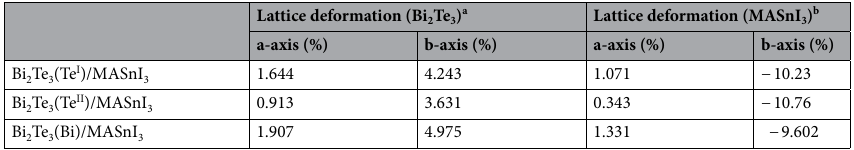
Table 2. Lattice deformation ratios of various interfaces after structural optimization. a This value represents the lattice deformation ratio of the Bi 2 Te 3 structure in the interface model based on the bulk orthorhombic Bi 2 Te 3 bulk structure before optimization. b This value represents the lattice deformation ratio of the MASnI 3 structure in the interface model based on the tetragonal MASnI 3 bulk structure before optimization.